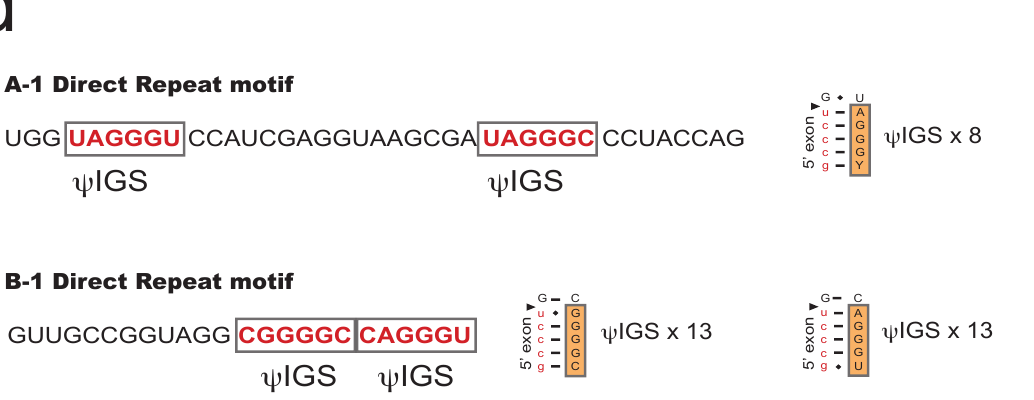
Figure 2. Structural features of the Mucilago crustacea S1389 group I intron. ( a ) Secondary structure diagram of the 1274-nt M. crustacea S1389 group IC1 intron S1389, presented according to [4]. The intron has a strong P1/P10 exon binding region of 11 base pairs (red box) and a large extension in P9 that contains direct repeat motifs (blue box). P1-P10, paired RNA segments; 5’ SS and 3’SS, exon–intron splice sites; IGS, internal guide sequence. ( b ) Helix 28 (H28) in SSU rRNA becomes completely disrupted when the S1389 intron is present. ( c ) The P9 insertion contains two repeat motifs (A and B) with Ψ IGS sequences (red boxes). ( d ) Sequential features of the repeats and putative exon base pair